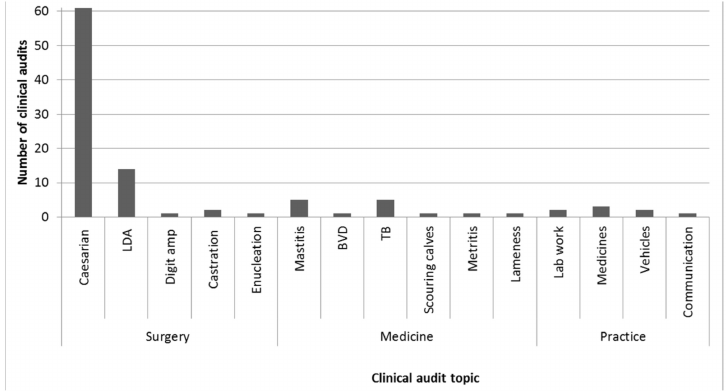
Figure 1. The topic of the most recent clinical audit conducted by the questionnaire respondents in a survey investigating the experiences and attitudes of UK farm animal clinicians towards clinical audit ( n = 101). LDA = left displaced abomasum, Digit amp = digit amputation, BVD = bovine viral diarrhoea, TB = bovine